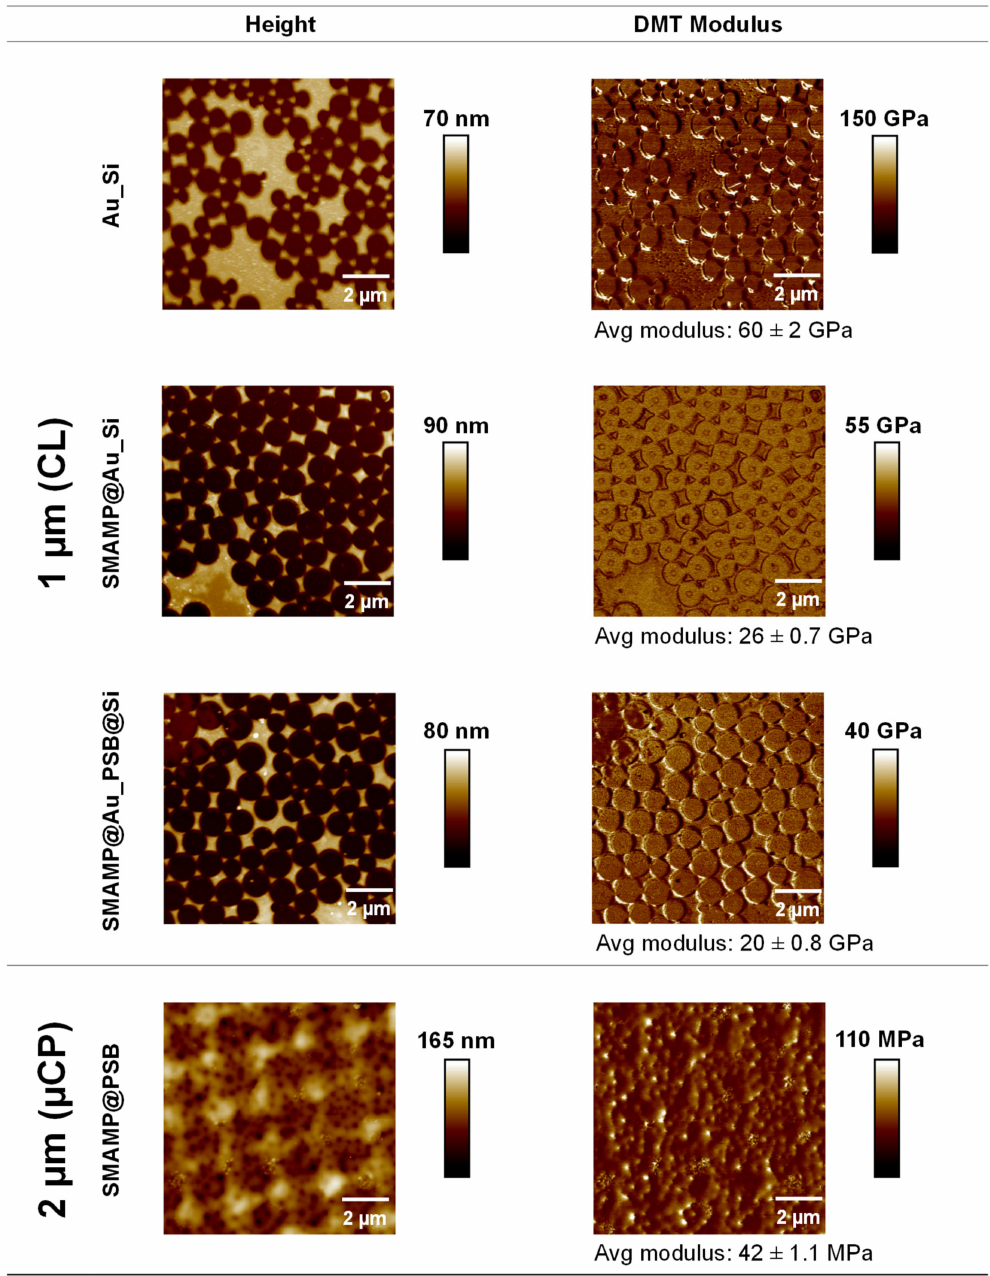
Figure 3. AFM height and QNM images of the 2D structured surfaces fabricated by CL (top rows, 1 µ m spacing), and 3D structured surfaces obtained by µ CP (bottom row, 2 µ m spacing). Avg =